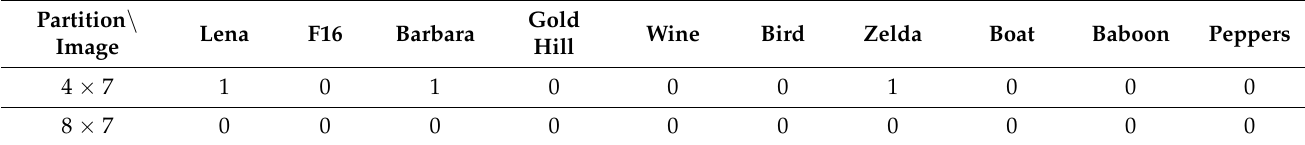
Table 4. Number of irreversible blocks when a block contains six different pixels. Partition